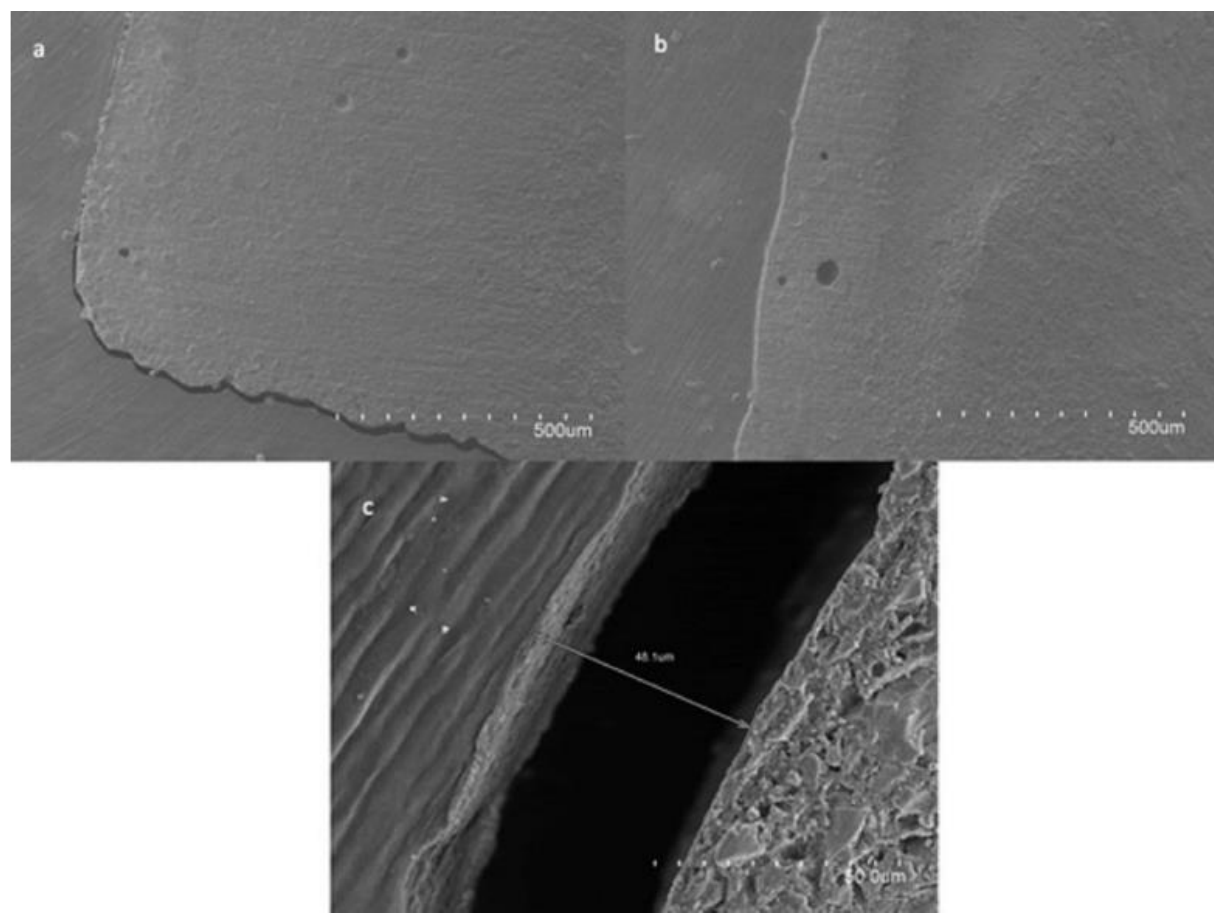
Figure 2. Representative SEM images of the samples. Images at 100× magnification with interfacial gap ( a ) and without interfacial gap ( b ), and image at 1000× magnification measuring the maximum interfacial gap ( c ). Scale bar: the distance between two points represents 50 µm in panels a and b (magnification × 100), and 5 µm in figure c (magnification × 1000).